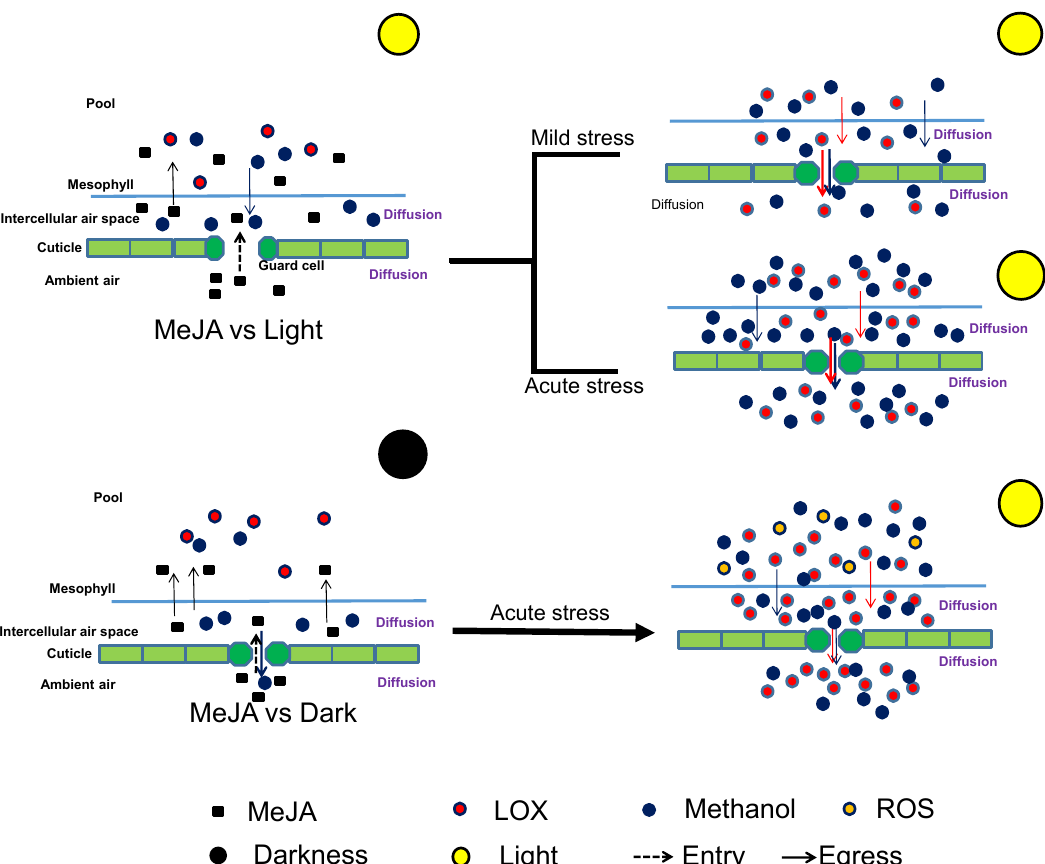
Figure 5. Schematic model of the relationships between rapid constitutive emission of volatiles and the role of stomata and cuticle by MeJA treatment interacting with light